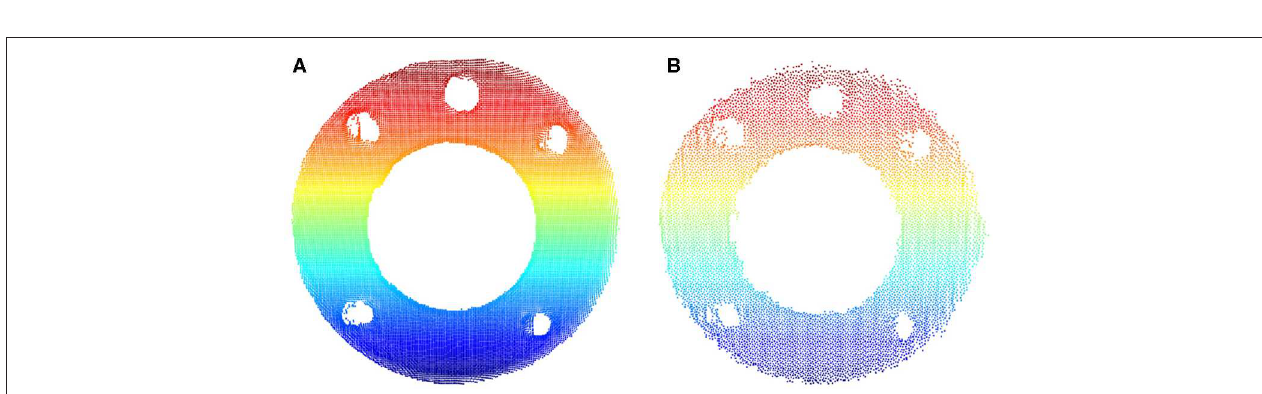
FIGURE 9 | Comparison of the captured point clouds about the robot flange in different motion modes. (A) Static scan. (B) Scanned in motion.